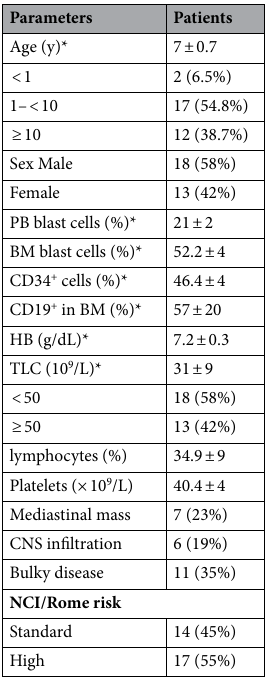
Table 1. Main characteristics of B-cell acute lymphoblastic leukemia patients. PB peripheral blood, BM bone marrow, HB hemoglobin, TLC total leukocyte count, CNS cerebral nervous system, NCI National Cancer Institute Standard risk: age 1– < 10 with initial TLC < 50 × 10 9 /L, High risk: all other patients, including patients with CNS leukemia at diagnosis. Results expressed as number (percentage), * expressed as mean ± SD.